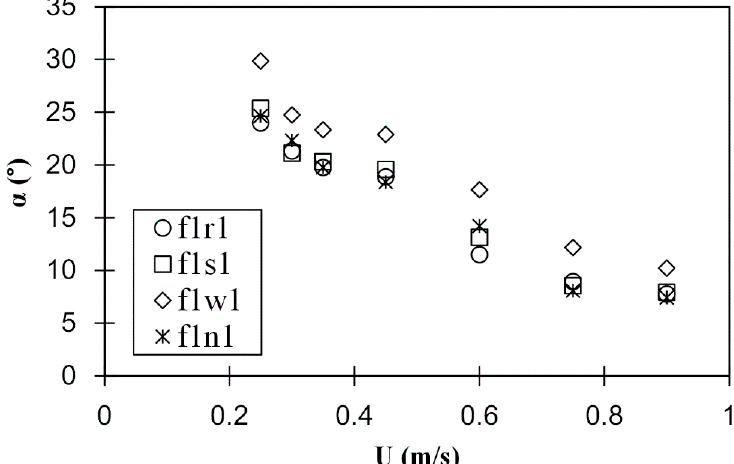
Figure 7. The variation of wake angle under different flow conditions with the penetration of the round metallic rod where the submergence distance (d) is equal to the flume water depth (h).